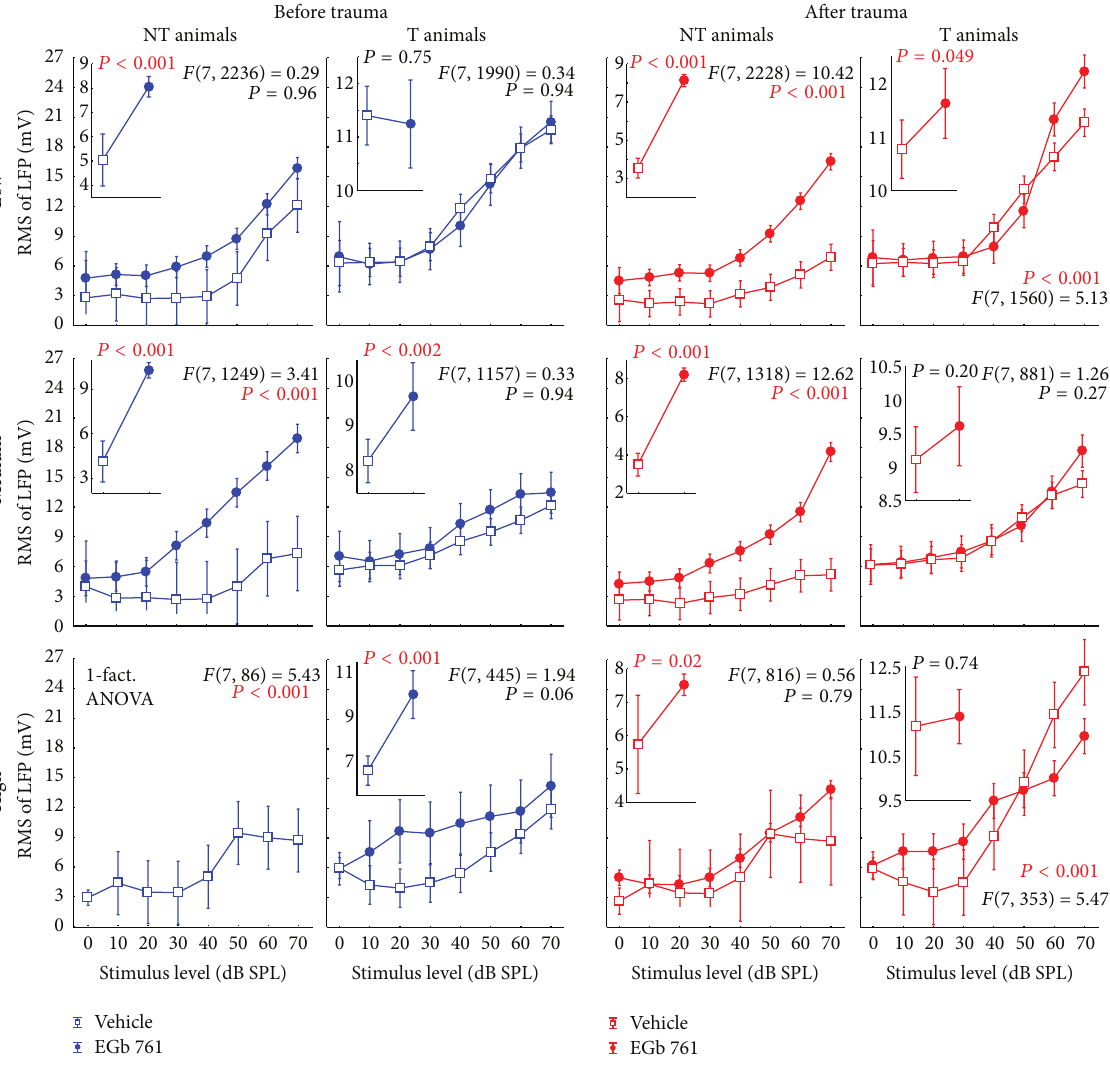
Figure 16: Replotted data of Figure 9, grouped according to the time of measurement (before versus after trauma) to allow for an easier comparison of vehicle versus EGB 761 treated animals. Note the consistent differences in the LFP amplitudes, in particular in the NT animals in vehicle versus EGB 761 treated